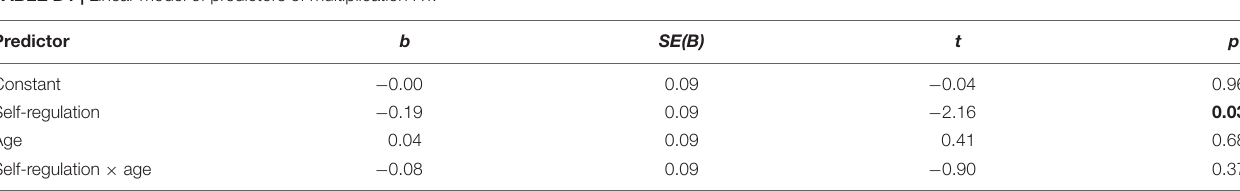
TABLE D1 | Linear model of predictors of multiplication RT.